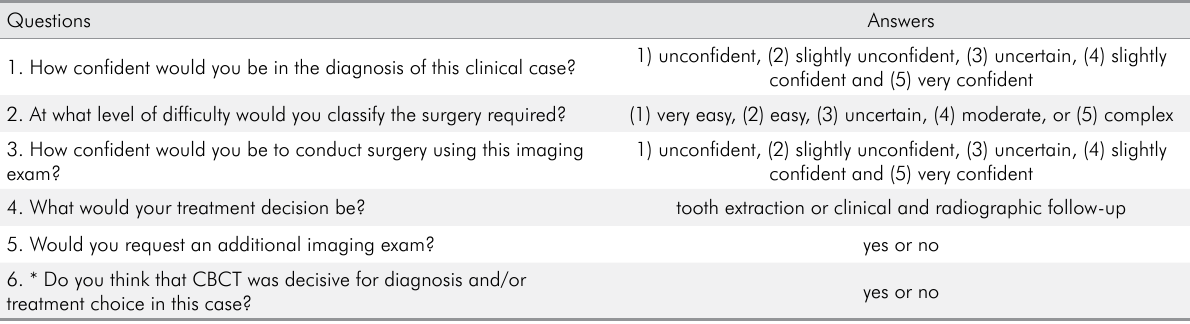
Table 1. A report of the questionnaire’s questions.